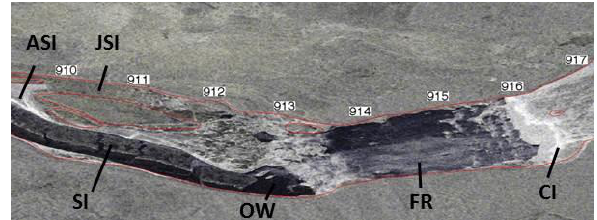
Figure 3. Examples of selected classes. Abbreviations: SI for skim ice, ASI for agglomerated skim ice, JSI for juxtaposed skim ice, FR for frazil run, CI for consolidated ice (frazil or skim ice) and OW for open